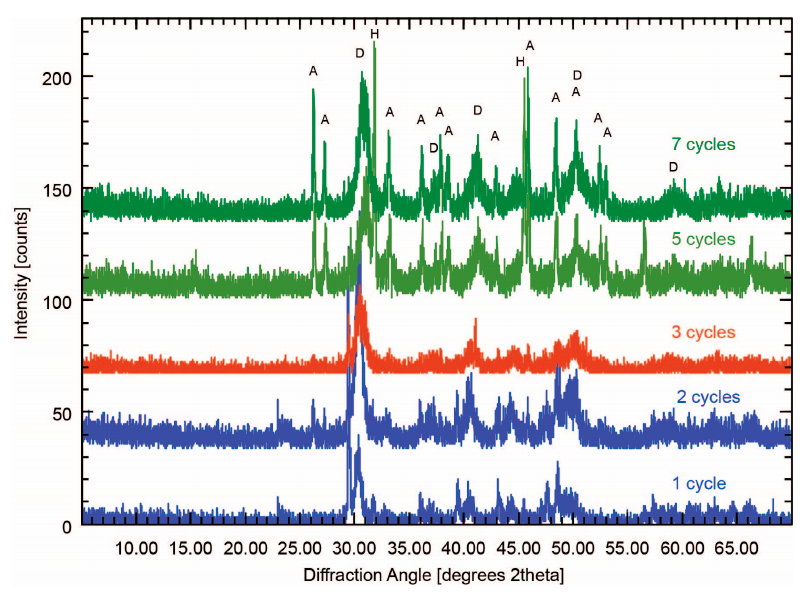
Figure 1. Powder X-ray diffractograms of reaction solids after 1, 2, 3, 5 and 7 diel cycles (each indicated by a different colour) in the first (control) series of pH cycling experiments. The original calcite disappears and instead aragonite (A) and (very) high magnesium calcite (D) forms with a gradual shift towards higher Mg incorporation. Some undissolved halite (H) is also identified.